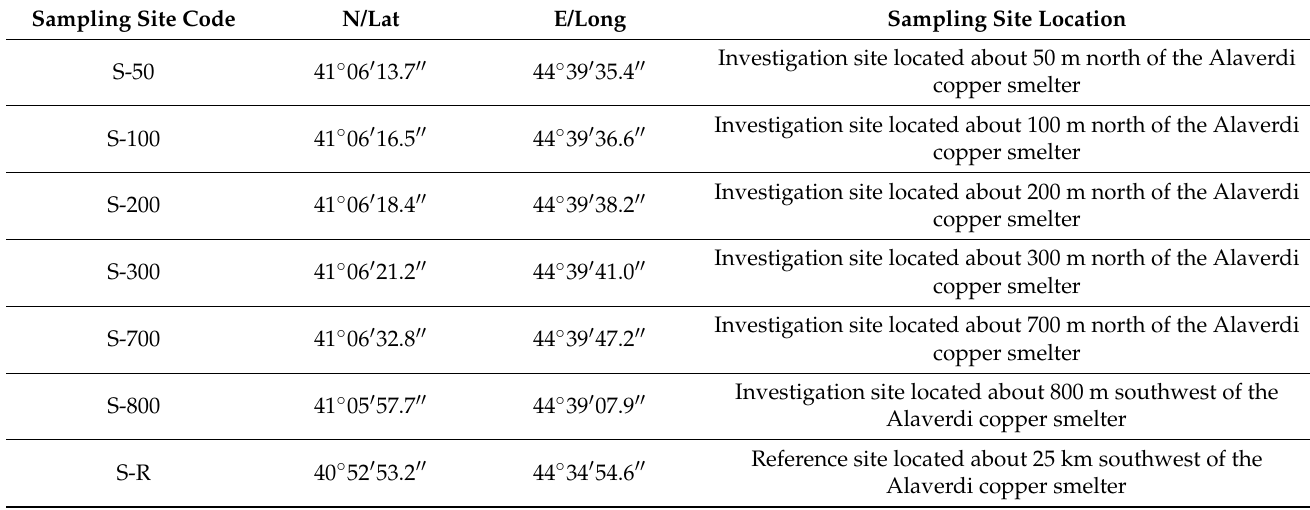
Figure 1. Location of the study area in Armenia and investigation sites as coded in Table 1. Table 1. Coordinates of sampling sites located at different distances from the Alaverdi copper smelter.